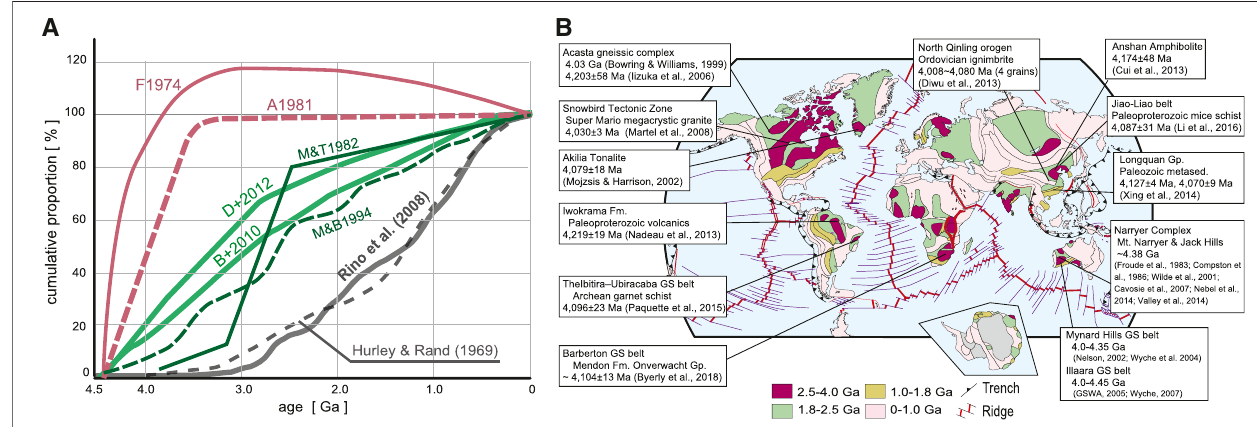
FIGURE1|(A) Previousgrowthmodelsofthecontinentalcrust(F1978:Fyfe,s1978;A1981:Armstrong,1981;MandT1982:McLennanandTaylor,1982;MandB 1994:McCullochandBennett,1994;B+2010:Belousovaetal.,2010;D+2012:Dhuimeetal.,2012).Blacksolidanddashedlinesshowtheagestructureofthemodern continents based on geochronological data (Hurley and Rand, 1969; Rino et al., 2008) which commonly indicate the rareness ofthe ancient crust in modern continents. The growth curves of the continental crust differs largely between studies, considering the great effects of crustal recycling/reworking (red lines) and the limited effects of crustal recycling/reworking (green lines). (B) Geotectonic map of the modern continents with localities of Hadean zircon grains modi fi ed after Tsutsumi et al. (2018) (GS, Greenstone). The abundant occurrence of Hadean detrital zircon is limited in ca. 3.0 – 3.3 Ga sandstone and quartzose clastic rocks (Froude et al., 1983; Compston and Pidgeon, 1986; Wilde et al., 2001; Cavosie et al., 2007; Nebel et al., 2014; Valley et al., 2014; Nelson, 2002; Wyche et al., 2004; GSWA; 2005; Wyche, 2007;Paquette et al.,2015;Byerly etal.,2018), eventhoughmanyoddlocalitieshave beenreported(Mojzsis andHarrison, 2002;Iizuka etal.,2006;Marteletal.,2008; Diwu et al., 2013; Nadeau et al., 2013; Cui et al., 2013; Xing et al., 2014; Li et al., 2016).